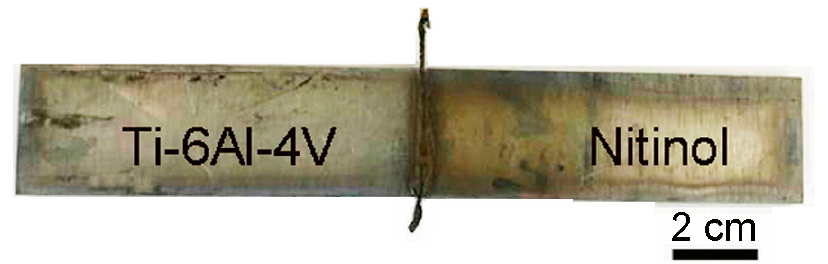
Figure 4. A successfully bonded Ti-6Al-4V/Nitinol dissimilar linear friction weld.